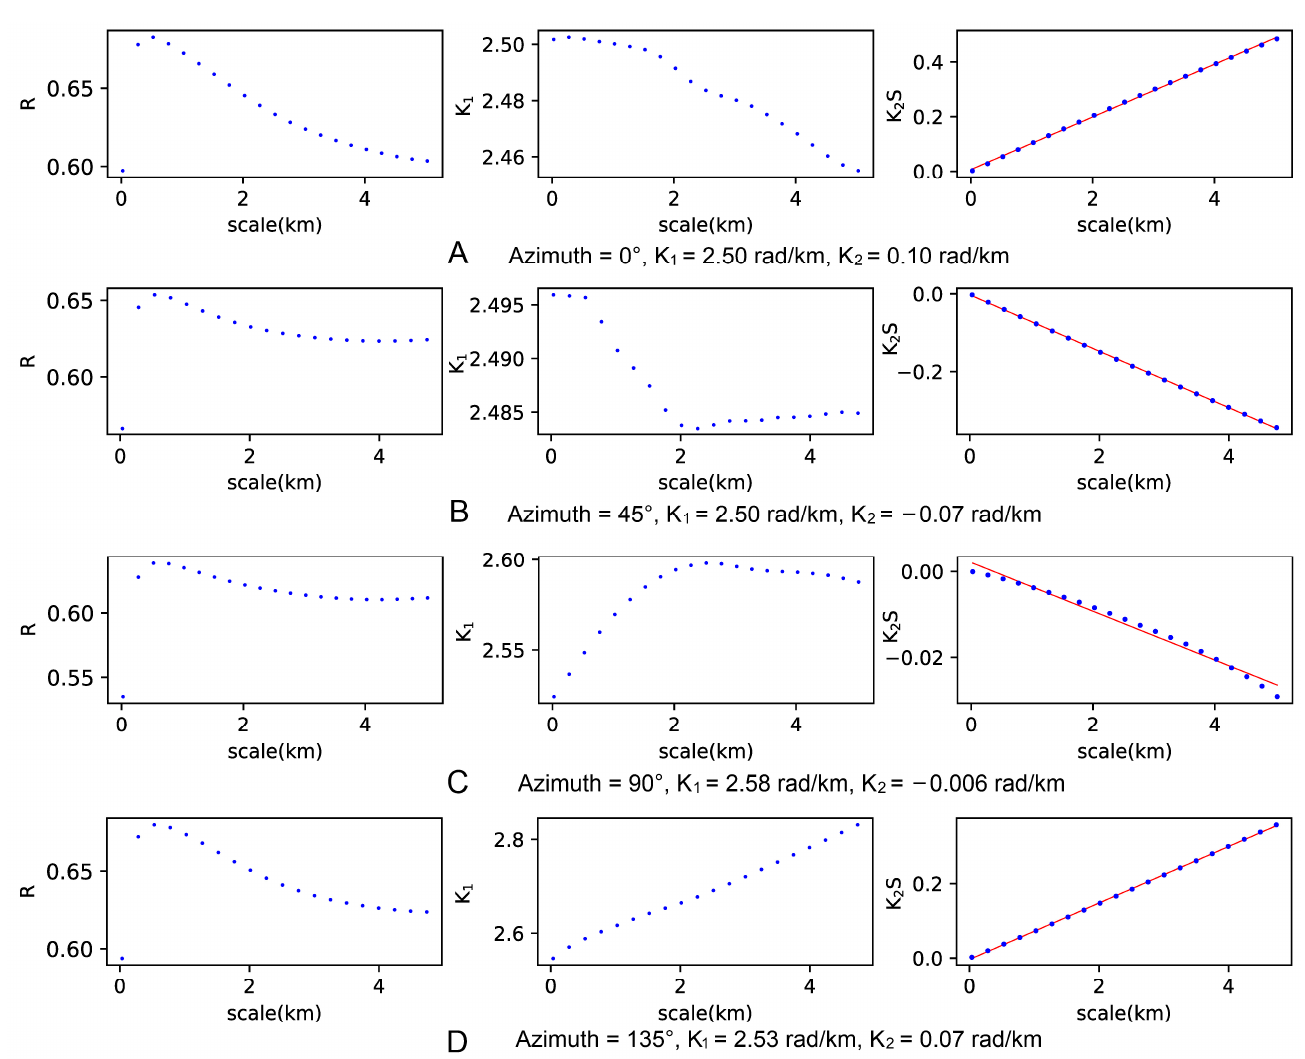
Figure 2. Values of the correlation coefficient R (column 1), K 1 (column 2), and K 2 S (column 3, blue dots, the red line is the fitting line of the blue dots) after the difference of multiple scales in four directions; the final K 1 is estimated according to the proposed method. The interval of the difference scale factor is 0.25 km, and the first scale factor is 0.025 km. The maximum absolute value of K 2 is 0.10 rad/km ( A ), the corresponding azimuth is 0 ◦ , and the related K 1 is 2.50 rad/km. The K 2 values of other azimuth ( B – D ) are all less than 0.1